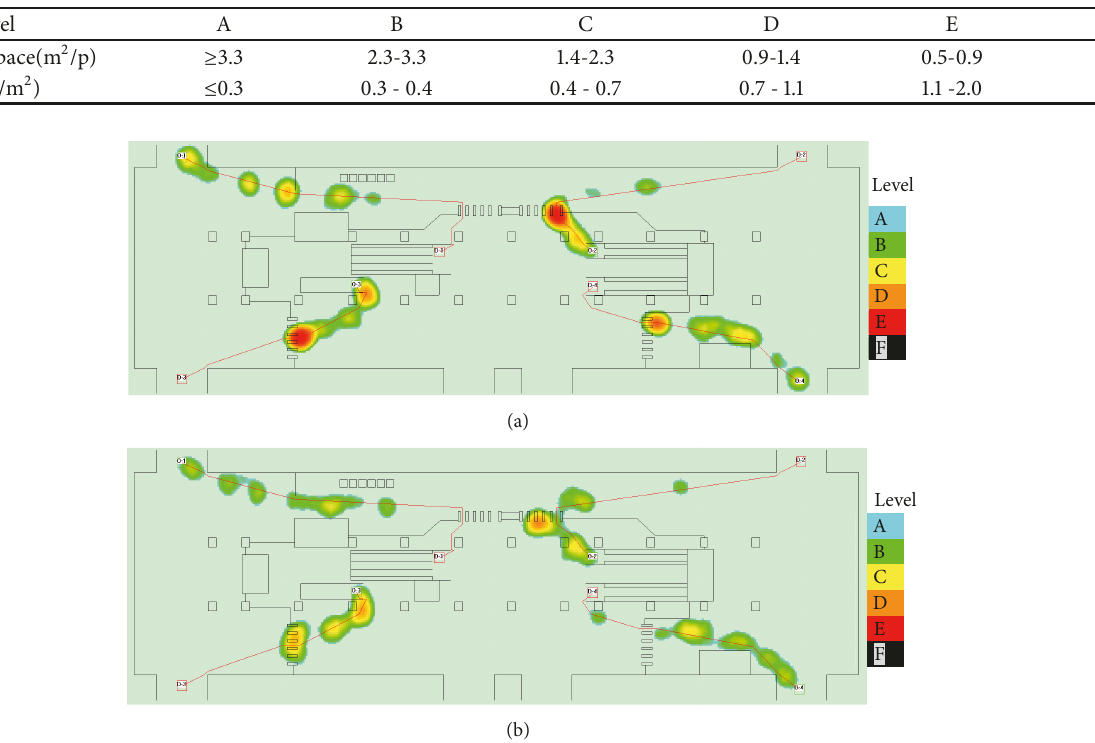
Figure 16: Mapped LOS in a station (T=26s), (a) only global route planning and (b) two-level route planning.